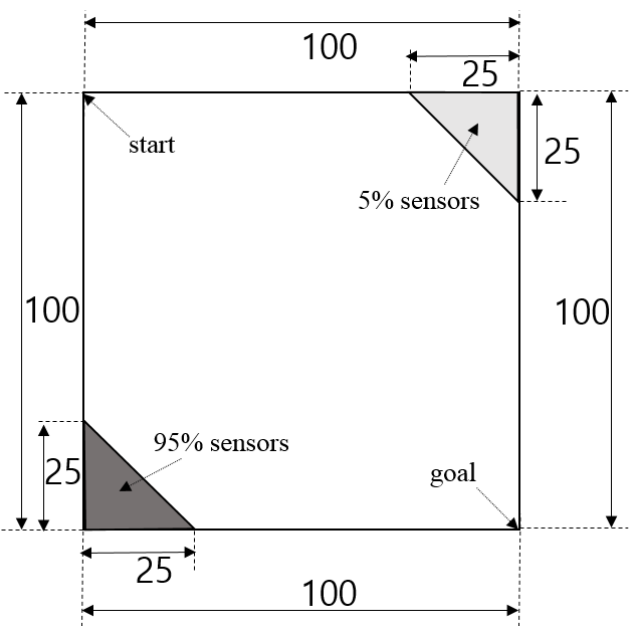
Figure 4. Weighted cluster deployment of sensors.